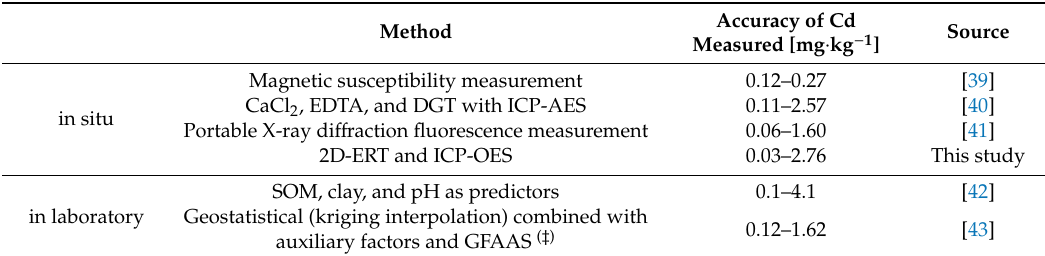
Table 2. Cd detection using several methods in agricultural